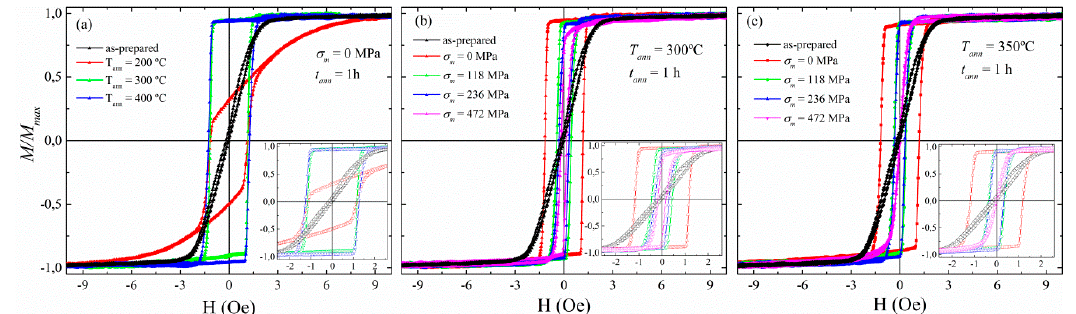
Figure 1. ( a ) Hysteresis loops (HLs) of the as-prepared and the annealed microwires performed at 200 °C, 300 °C, and 400 °C. Subfigures ( b ) and ( c ) show HLs of as-prepared and stress-annealed performed at T ann = 300 and 350 °C, respectively. The thermal treatments on the parent-microwire Co 69.2 Fe 3.6 Ni 1 B 12.5 Si 11 Mo 1.5 C 1.2 were performed for 1h. In the insets, it is shown a magnification of the